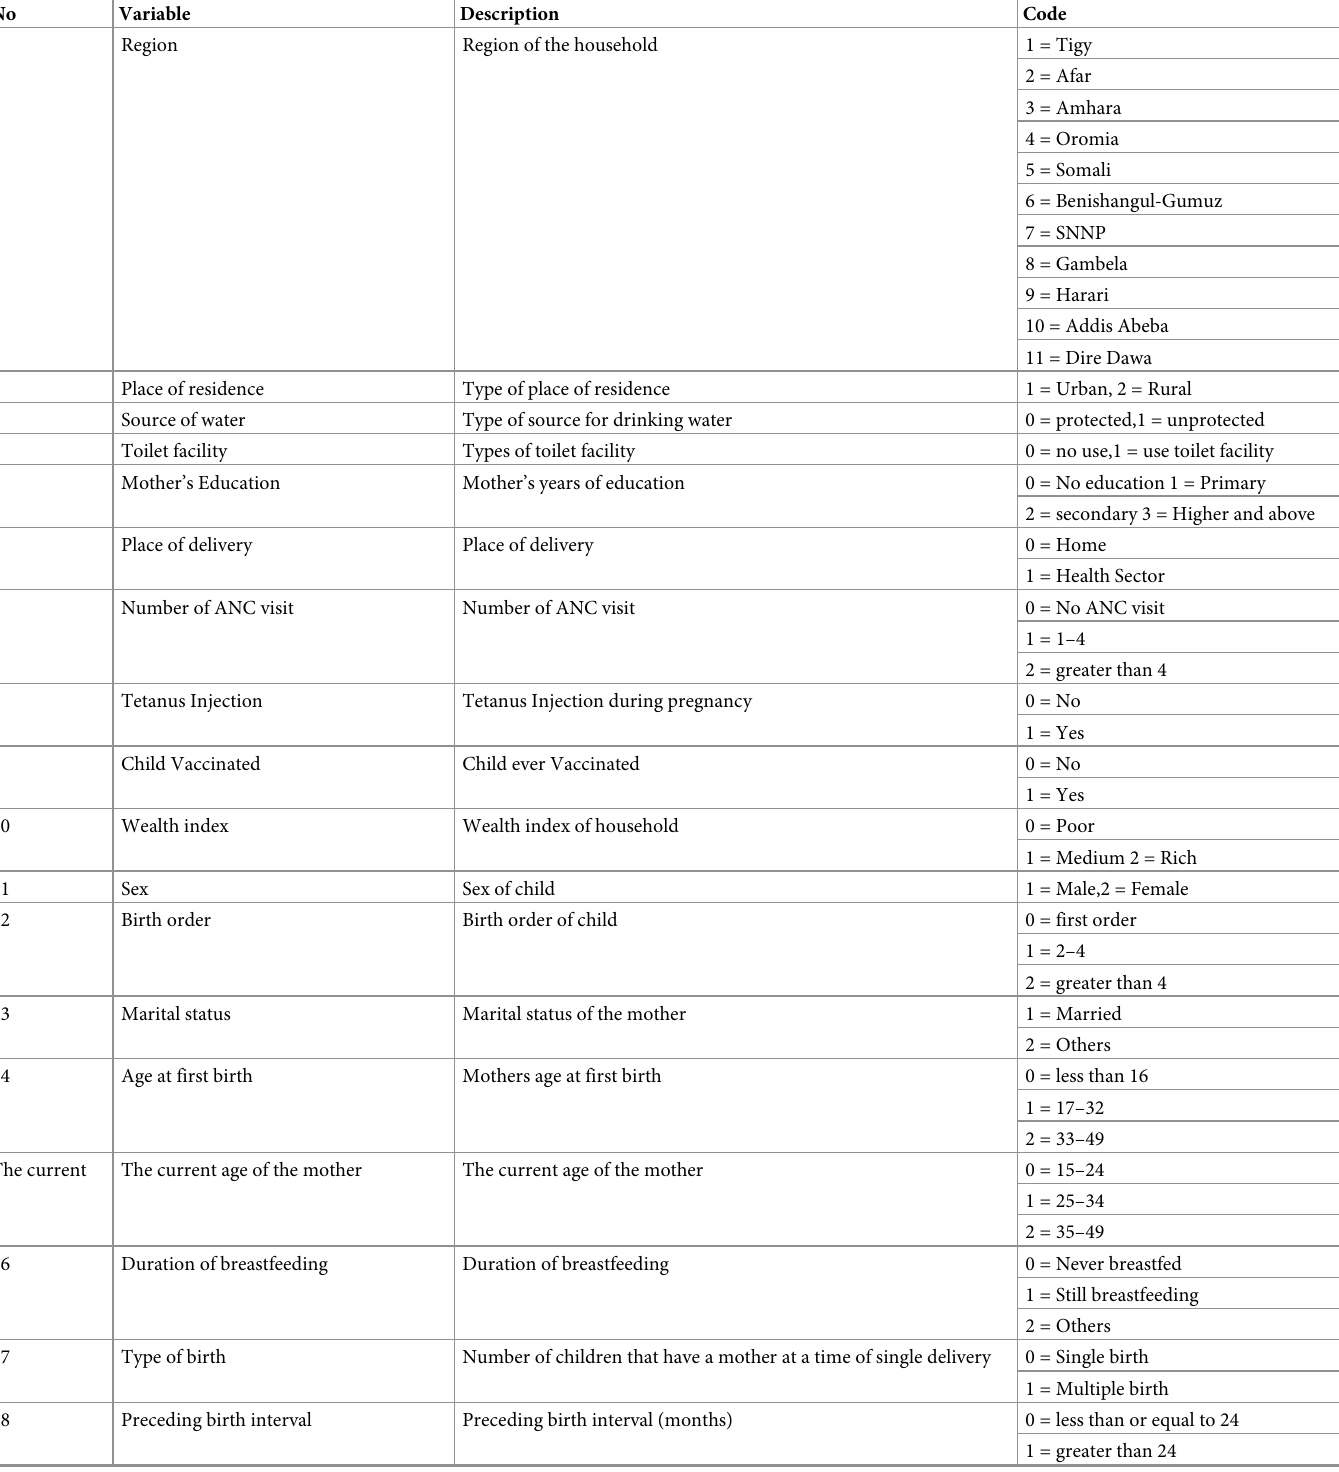
Table 1. Coding and description of explanatory